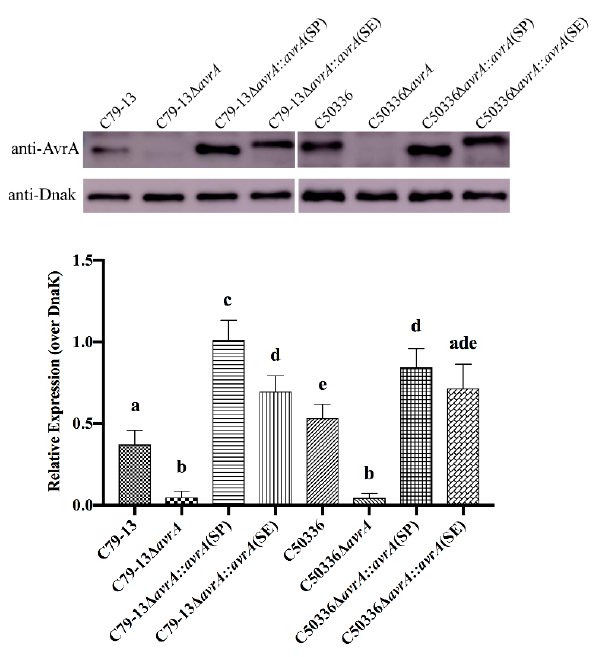
Figure 8. Identification of AvrA expression in C79-13 and C50336 by Western blot analysis. The overnight cultured bacteria were lysed using ultrasonic treatment and subjected to Western blot assay with mouse anti-AvrA sera as the primary antibody. The DnaK was used as the control. Protein band density was analyzed by using the NIH ImageJ software. Data are expressed as the mean + SD. The different letters on the error bars indicate statistically significant differences ( p < 0.05).